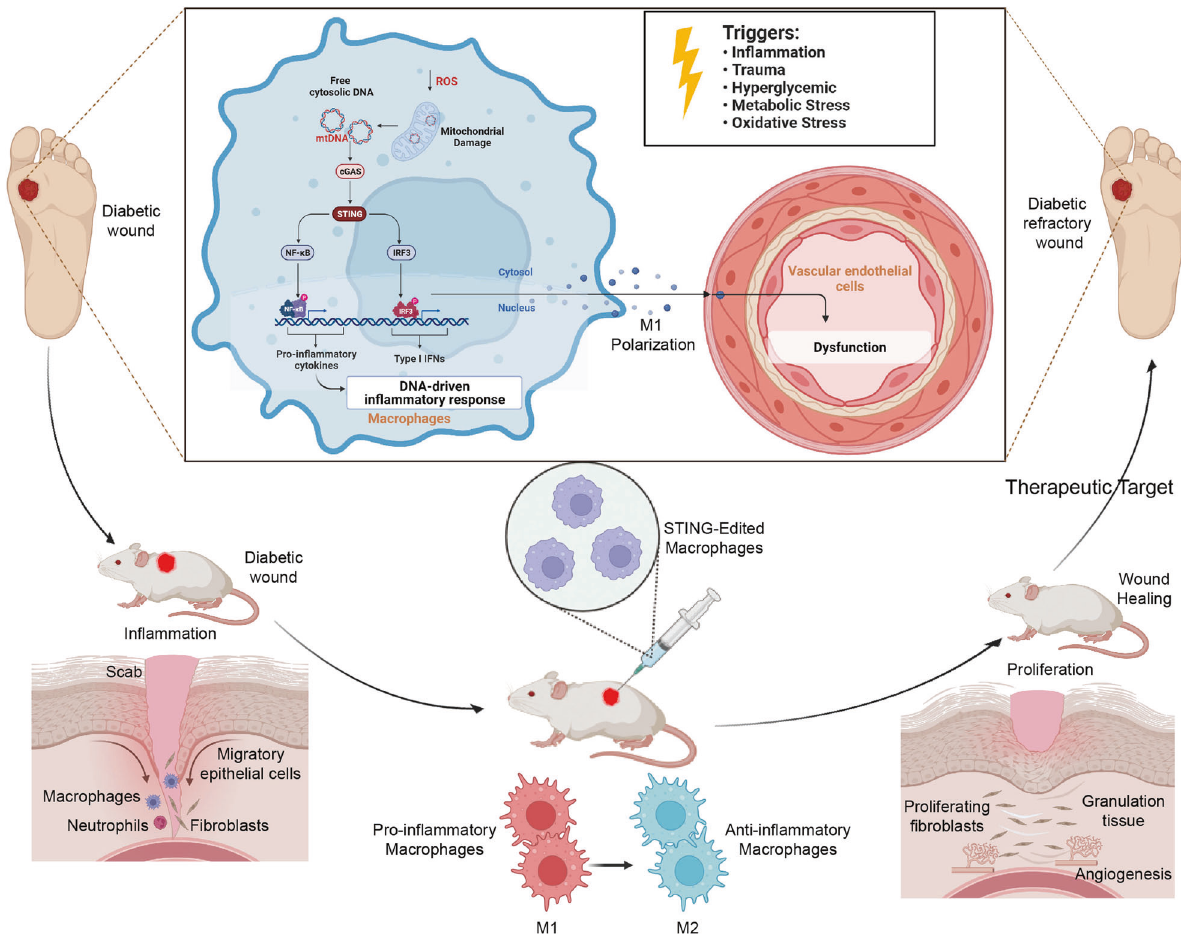
Fig. 8 Schematic diagram showing the proposed mechanism that involves STING signaling in wound healing in DW. HG-induced STING activation promoted M1 polarization of macrophages and aggravated DW healing